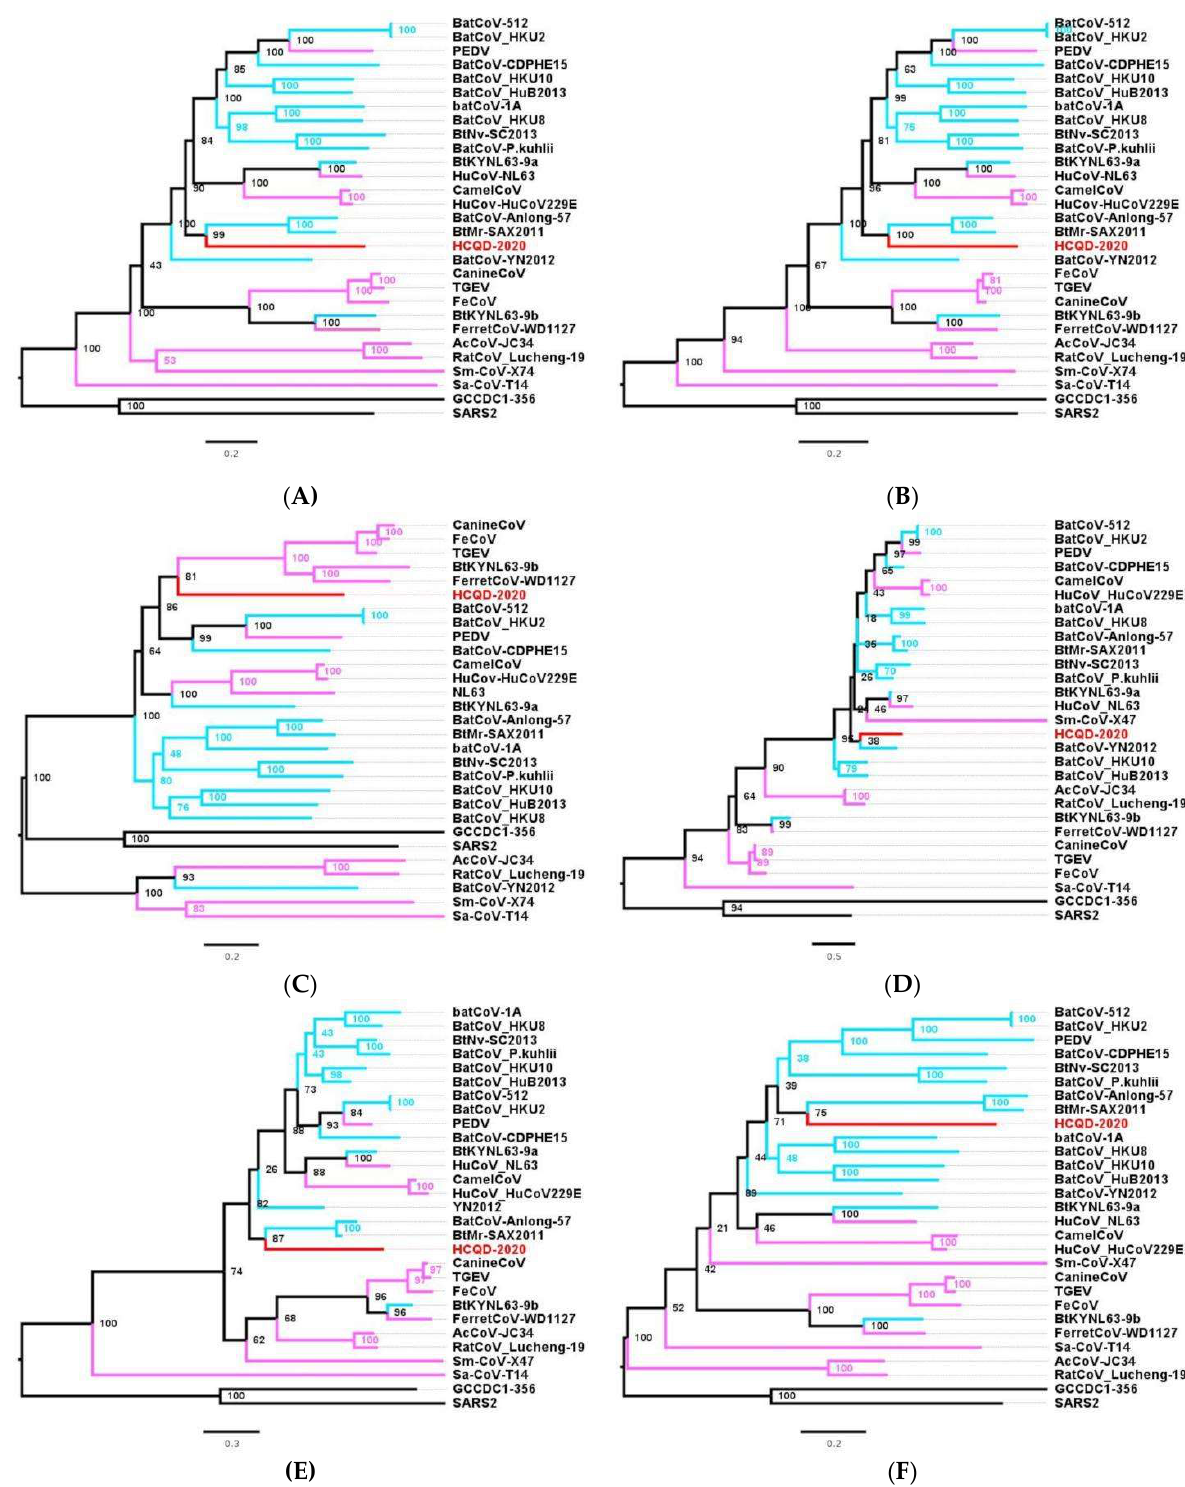
Figure 5. Phylogenetic analysis of the novel coronavirus based on the main nonstructural and structural protein-encoding genes. Phylogenetic tree construction based on the ORF1a ( A ), ORF1b ( B ), S ( C ), E ( D ), M ( E ), and N ( F ) genes, respectively. The present strain is highlighted in red. The coronavirus species originating from bats are presented in light blue while the nonbat mammalian host coronaviruses are labeled in pink. The scale bar indicates the number of substitutions per site.